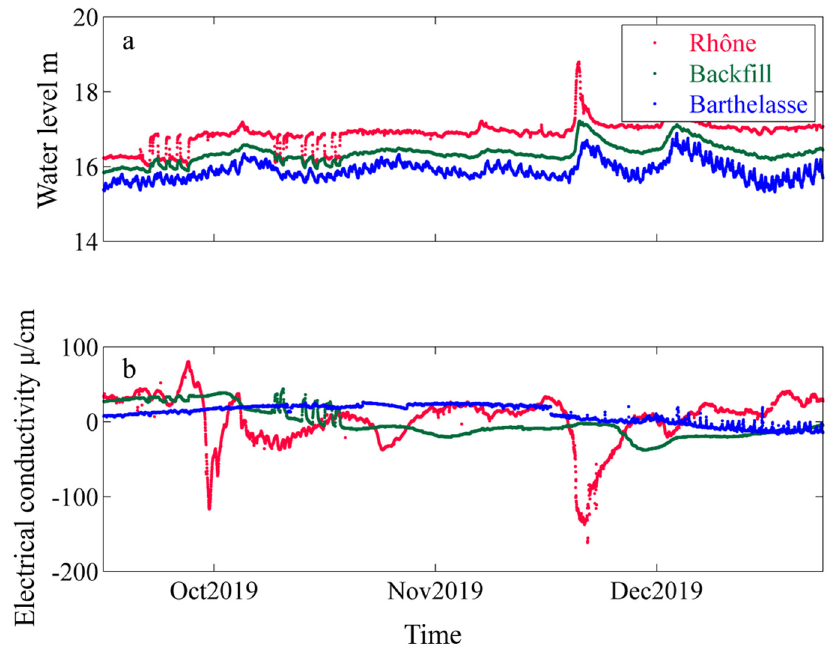
Figure 15. ( a )The water level fluctuation in the Rhône River, backfill and Barthelasse as a function of time. ( b ) Evolution of electrical conductivity after removal of annual and seasonal variations in the Rhône, backfill and Barthelasse as a function of time.